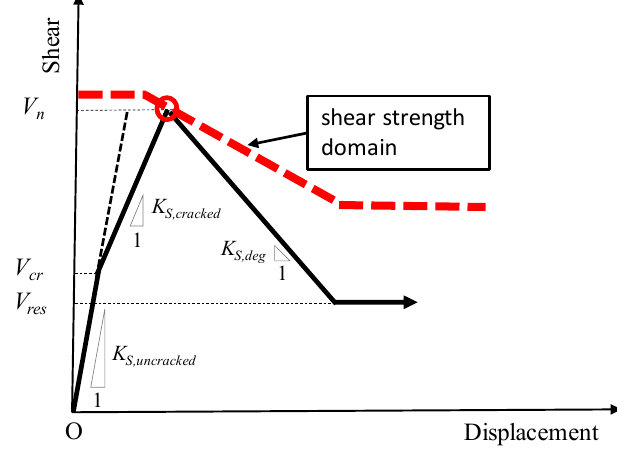
Figure 5. Phenomenological model for the shear spring.